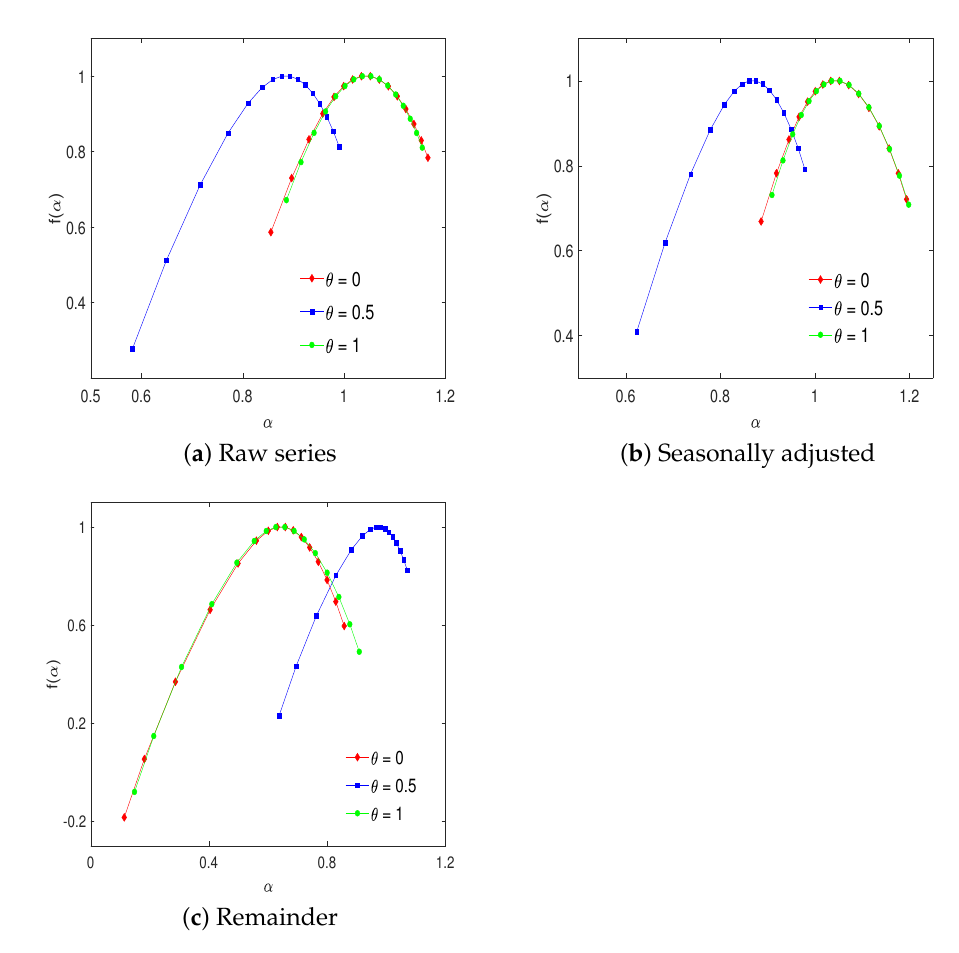
Figure 8. The multifractal spectra.